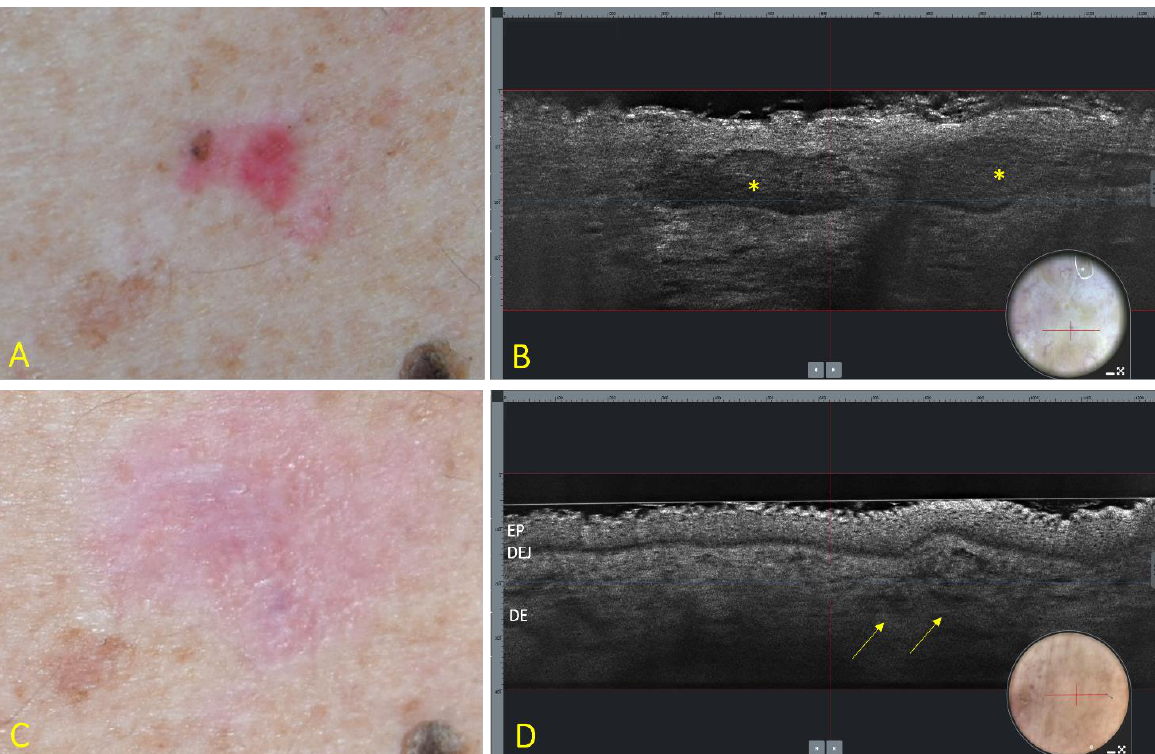
Figure 1. Superficial BCC of the trunk at baseline ( A , B ) and 4 weeks after the end of treatment with IQ 5% cream ( C , D ). ( A ) Clinical aspect showing a 16 × 14 mm, pink–reddish, and partially pigmented patch. ( B ) LC-OCT vertical section (field of view: 1200 × 250 μm) showing the presence of lobules (asterisks) connected to the epidermis, with an outer bright rim surrounding a middle dark rim, and an inner grey core with a “millefeuille” pattern. Insert: dermoscopy of the examined area (field of view: 1200 × 500 μm); the red line corresponds to the vertical section. ( C ) Clinical disappearance of the lesion with mild residual erythema. ( D ) LC-OCT showing disappearance of the lobules with persistence of dilated vessels (ar- rows). EP = epidermis; DEJ = dermoepidermal junction; DE = dermis. Insert: dermoscopy of the examined lesion (field of view: 1200 × 500 μm); the red line corresponds to the vertical section.